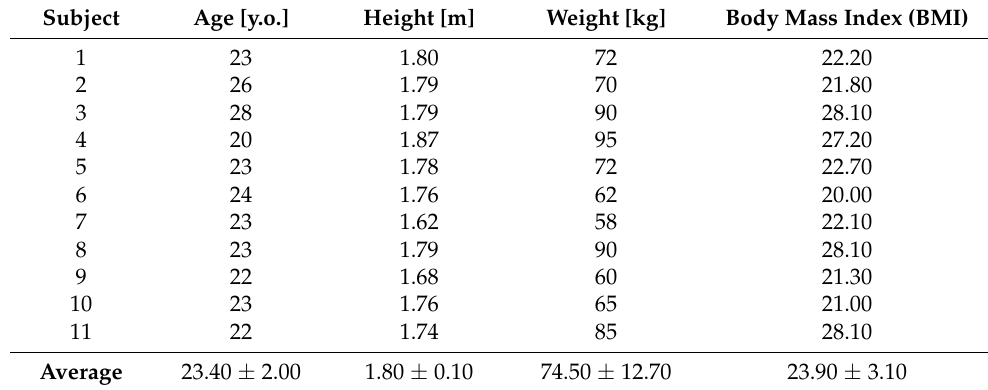
Table 1. Summary of anthropometric measures of the volunteers that participated in the